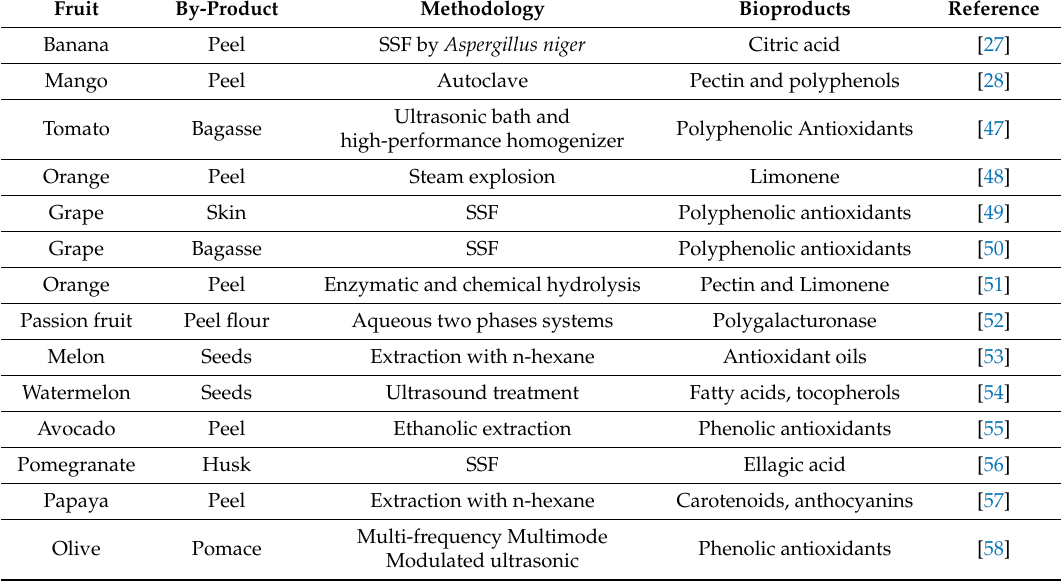
Table 2. Examples of bioproducts obtained from valorization of some fruit